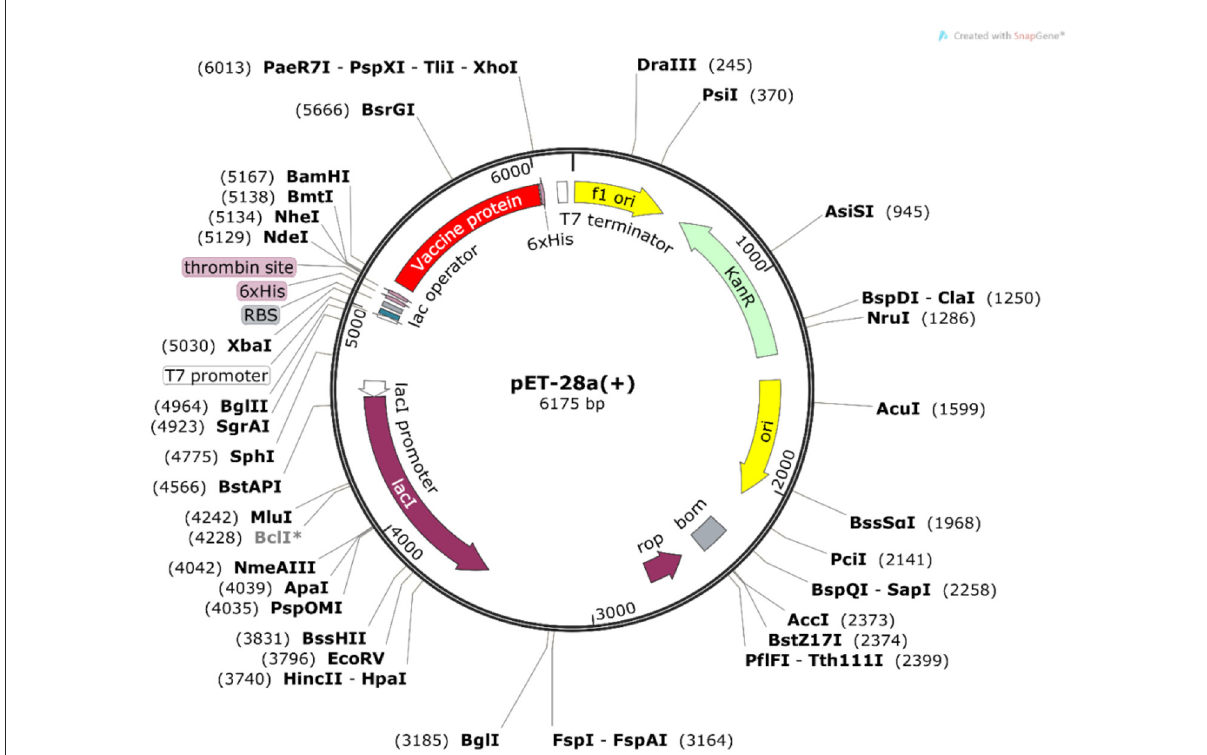
FIGURE10 In silico cloning of the vaccine construct. The codon-optimized DNA sequence of the vaccine construct (in red) was cloned between the BamH I and Xho I restriction sites of the pET-28a( + ) expression vector (shown in black circles).